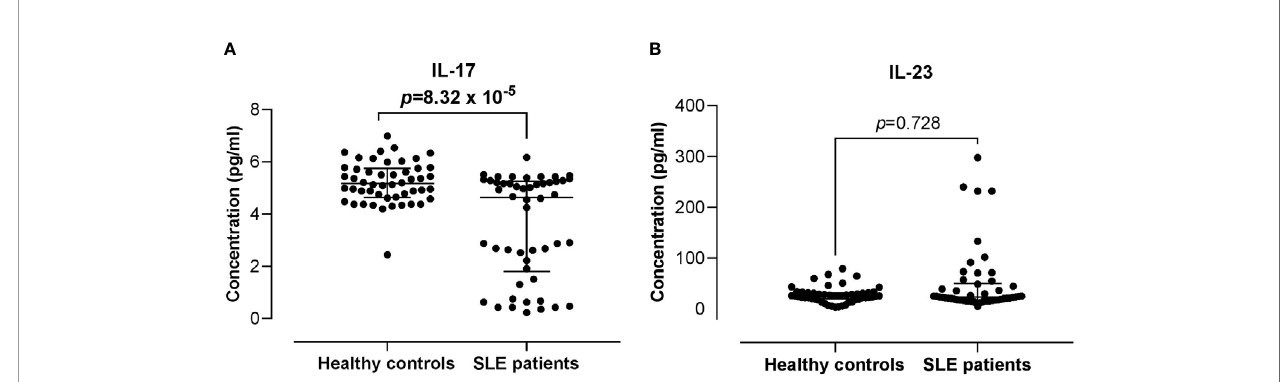
FIGURE 3 | Comparison of the serum IL-17 and IL-23 levels between SLE patients versus healthy controls. (A) IL-17 serum levels in SLE patients vs healthy controls. (B) IL-23 serum levels in SLE patients vs healthy controls. The bars in each scatter plot represent the median and interquartile range.